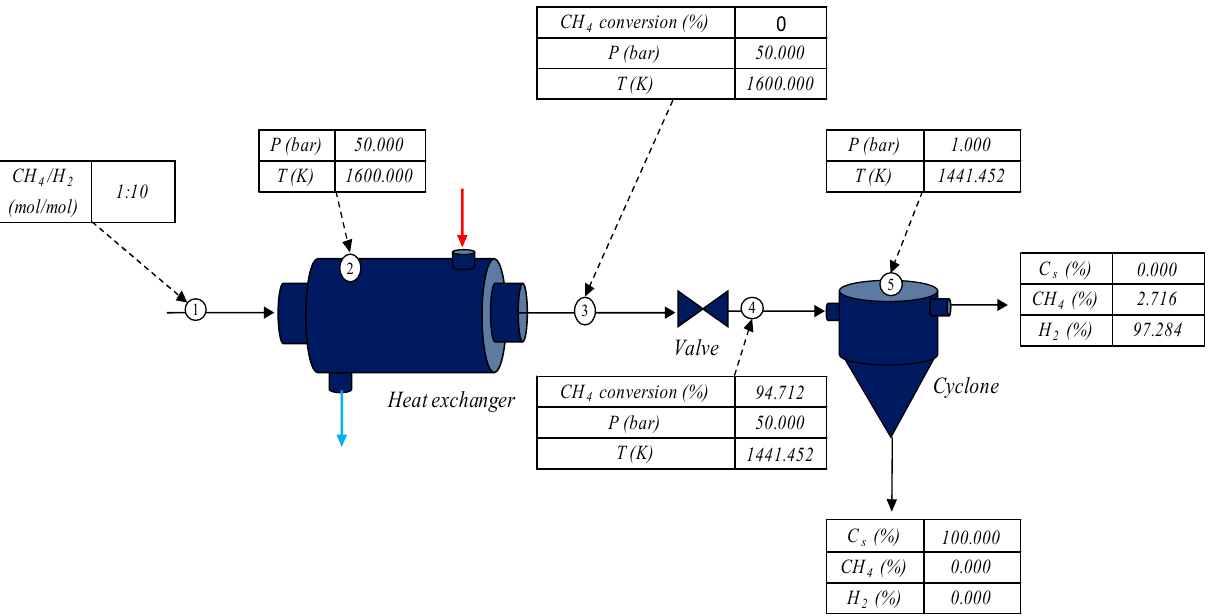
Figure 13. Theoretical operational conformation with optimal entropy maximization results.